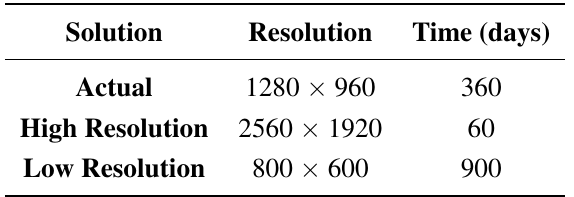
Table 2. Battery-based life time vs . image